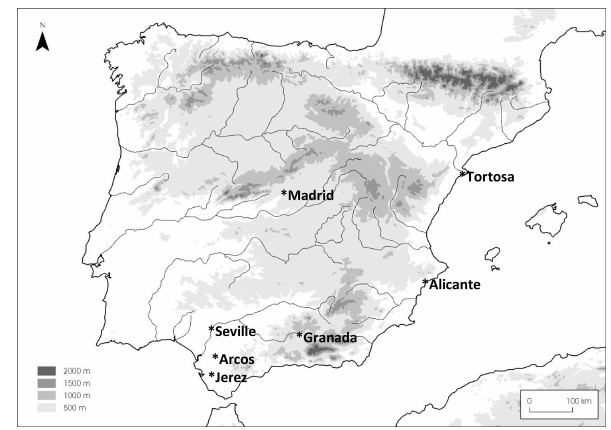
Figure 2. Location of Granada and other cities mentioned in the